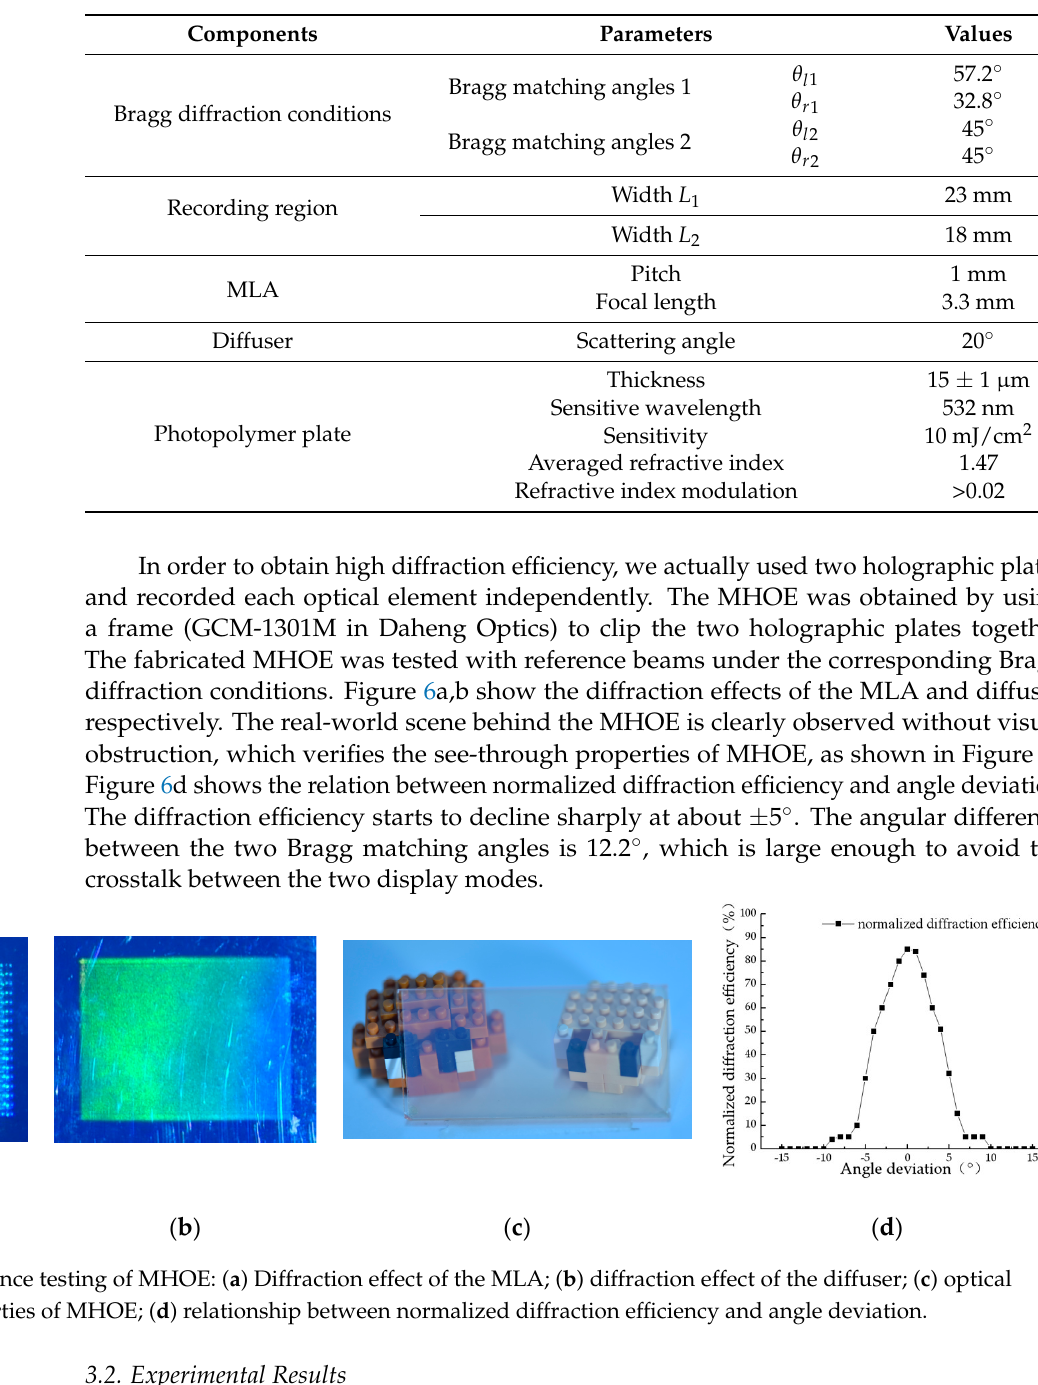
Table 1. Parameters of the experiment for recording process.